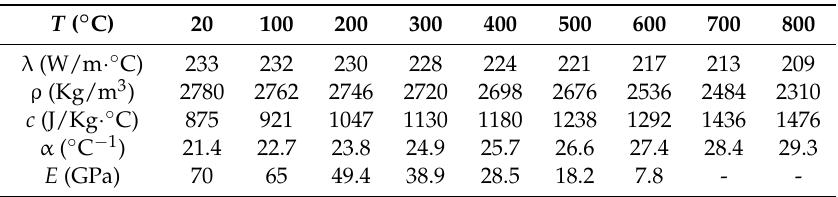
Figure 8. Temperature contour of the plane without cracks in the cooling process (40 < t < 180 s). ( a ) t = 50 s; ( b ) t = 80 s; ( c ) t = 100 s. Figures 7 and 8 represent the temperature distribution of aluminum alloy plate in the welding heating and cooling processes. It can be seen that the high temperature area mainly concentrates on the welding center area; the highest temperature zone moves as the heat source. The heating quantity diffuses to the heating affected zone, of which the temperature of the workpiece tends to be balanced. The calculated results are in good agreement with the existing ones. In addition, it can be seen that the heat conduction on the workpiece is continuous, and the temperature gradient is distributed in the welding heating and cooling processes.